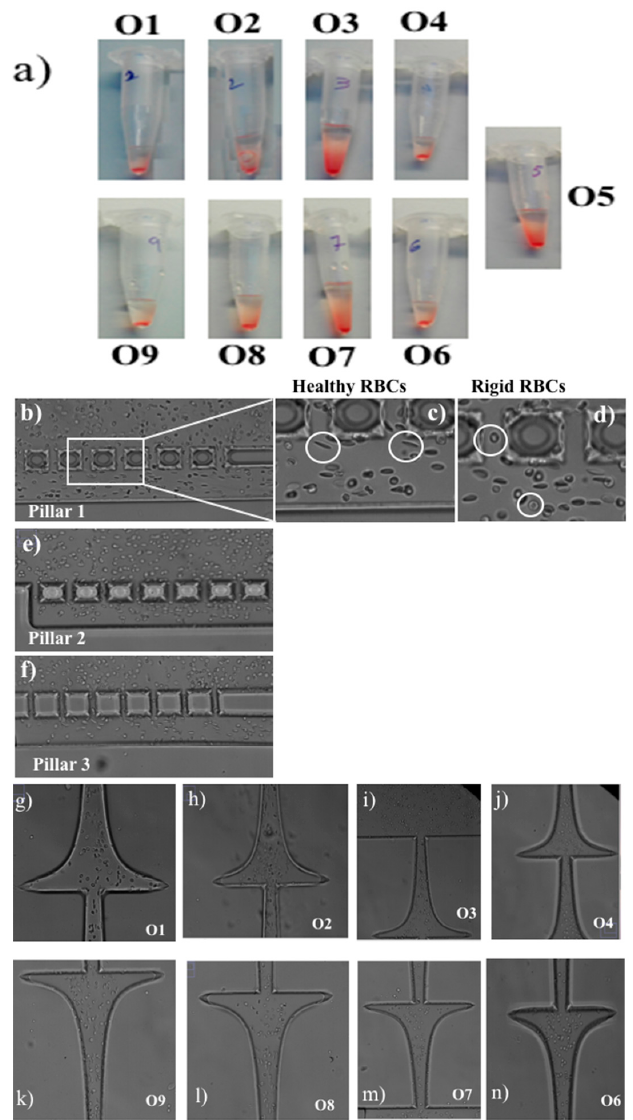
Figure 2. ( a ) Photo of the Eppendorf tubes with the samples collected in each outlet of the device; ( b ) pillars with a spacing of 17 µm; ( c ) elongated RBC; ( d ) rigid RBC; ( e , f ) pillars with spacing of 16 µm and 14 µm, respectively; ( g – n ) RBCs in each outlet O1–O9 of the microchannel (except for O5, where there was no hyperbolic contraction).